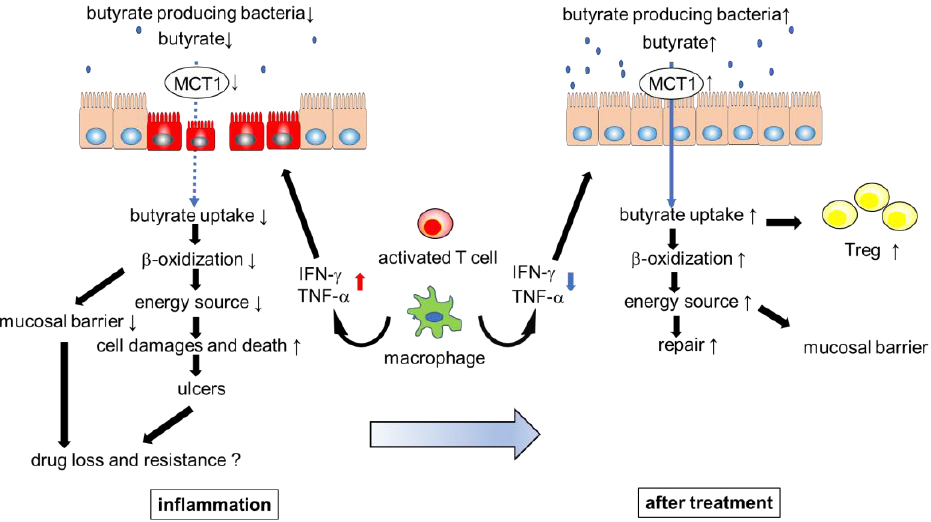
Figure 2. Inflammatory cytokines impair butyrate uptake, barrier function, and metabolism in intestinal epithelial cells (IECs). Inflammation and low abundance of butyrate contribute to the refractory nature of inflammatory bowel disease. Appropriate treatment ameliorates the inflammation that leads to dysbiosis and decreased butyrate uptake. As a result, increased butyrate levels in the colon contribute to gut homeostasis and drug